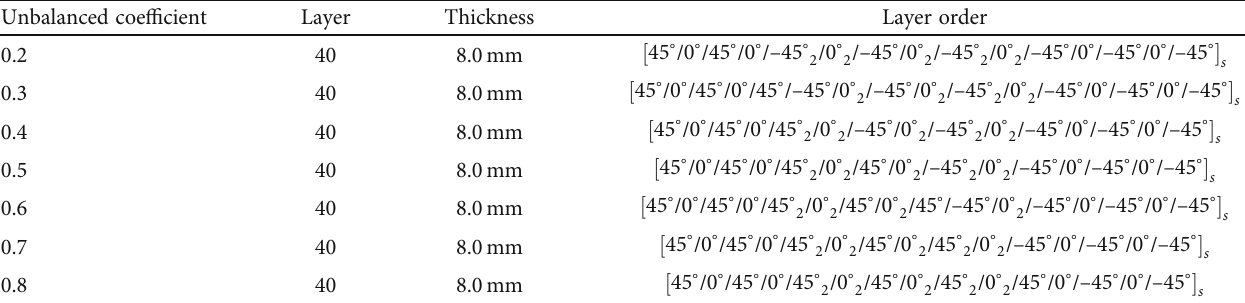
Table 3: Equal thickness layup